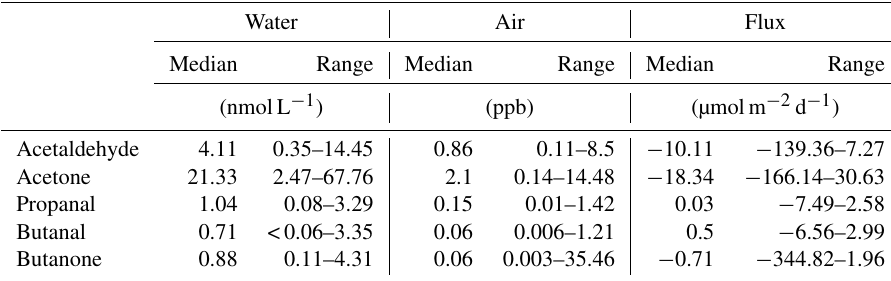
Table 1. Averages and ranges of water and air concentrations of OVOCs and their air–sea gas exchange rates. Negative flux values refer to gas exchange from the atmosphere into the ocean.